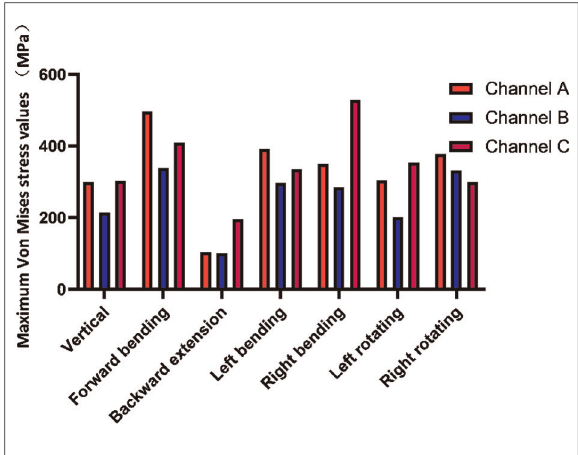
FIGURE 4 Maximum von mises stress of internal fi xation with three channels.